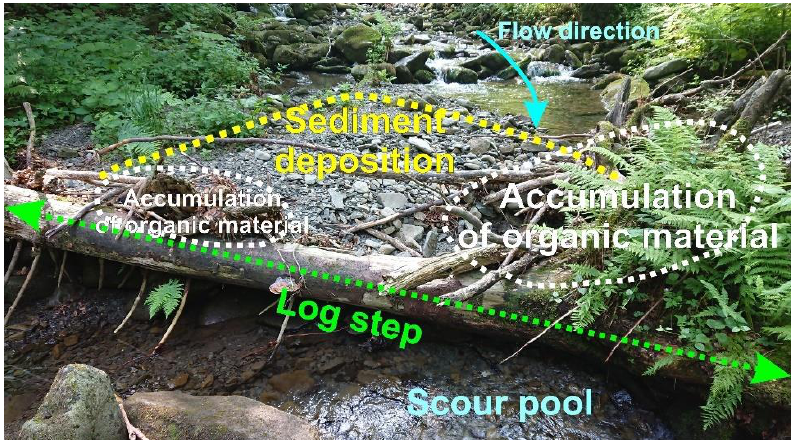
Figure 3. Geomorphic impact of a log step in a stream surrounded by an unmanaged forest (the Satina catchment). Such log steps are rare in the streams surrounded by forests under intensive management.